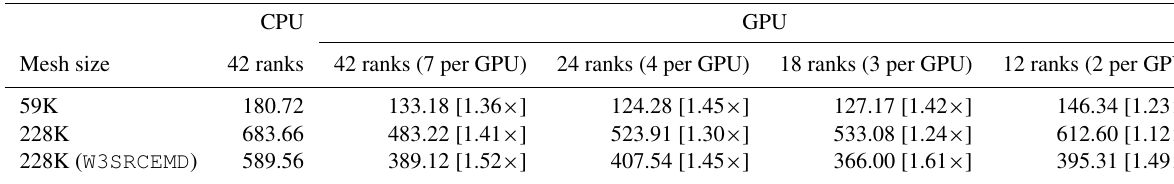
Table 3. Node baseline comparison runtime (seconds) with different MPI ranks per GPU configuration on a Summit node. The numbers in square brackets are the speedup relative to the whole CPU on a Summit node (42 MPI ranks). In the last row, we present the speedups and simulation times when comparing only the GPU-accelerated subroutine, W3SRCEMD .